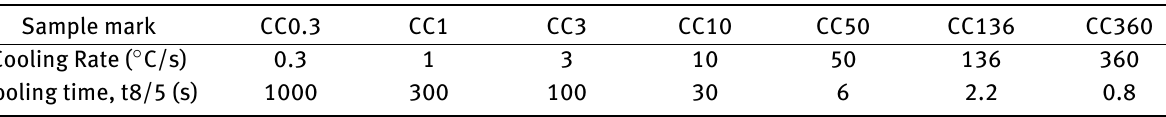
Table 2: Various cooling rates and times (t8/5) applied by dilatometer in order to obtain the samples under different weld simulated condi- tions in conjunction with their associated samples’